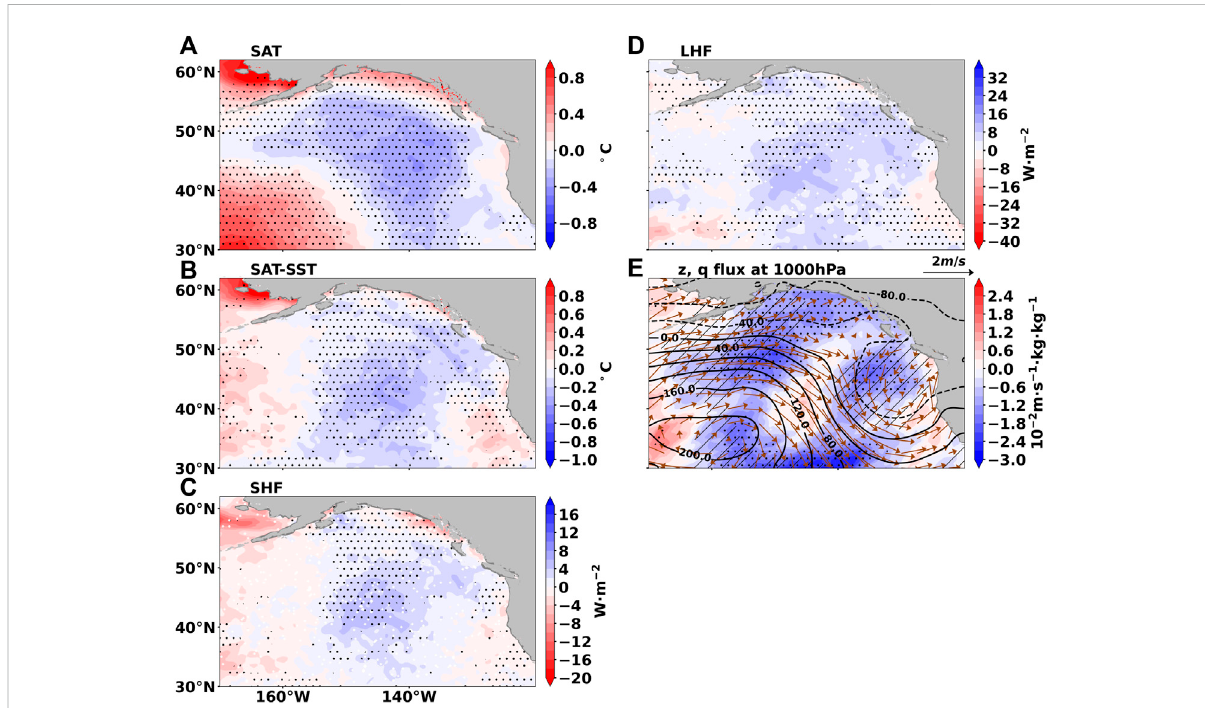
FIGURE 6 Difference between thermodynamic properties for cases of low clouds and fog. (A) SAT (shaded, ° C), the black dots indicate the SAT difference signi fi cant at the 95% con fi dence level. (B) SAT – SST (shaded, ° C); the black dots indicate the SAT – SST difference signi fi cant at the 95% con fi dence level. (C) SHF (shaded, W · m − 2 ); the black dots indicate the SHF difference signi fi cant at the 95% con fi dence level. (D) LHF (shaded, W · m − 2 ), the black dots indicate the LHF difference signi fi cant at the 95% con fi dence level. (E) Geopotential height (black contour, gpm), water fl ux